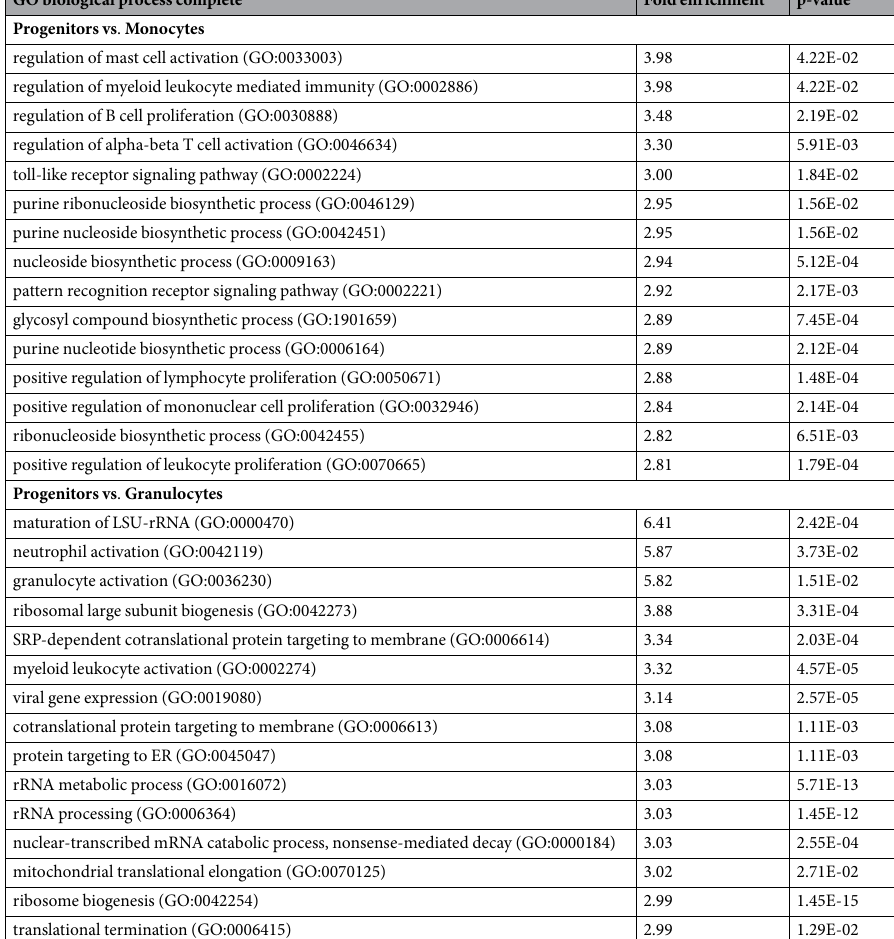
Table 3. The top 15 categories from gene ontology analysis performed on the top 2000 differentially expressed transcripts using the Panther database’s statistical over representation test with Bonferroni correction (www.